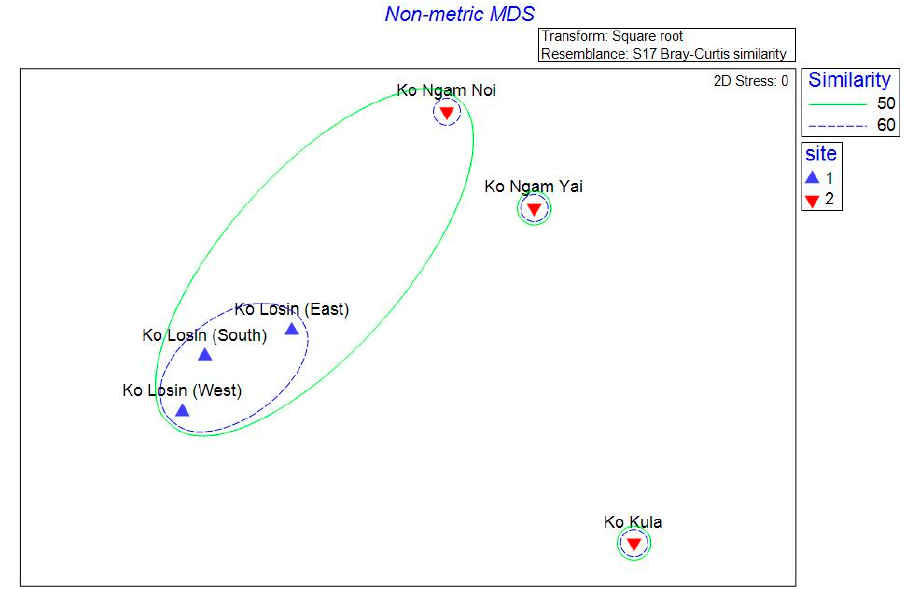
Figure 11. Two-dimensional NMDS plot of the composition of juvenile corals at the study sites. Table 3. SIMPER analysis of the composition of juvenile corals at the study sites.